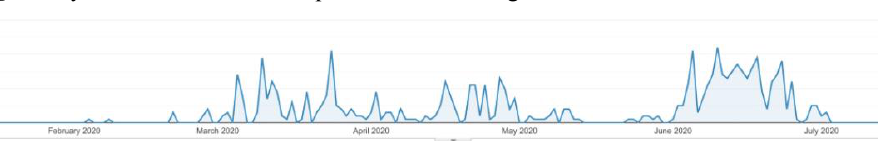
Fig. 7a. Dynamics of visits to the quanta Definite integral.